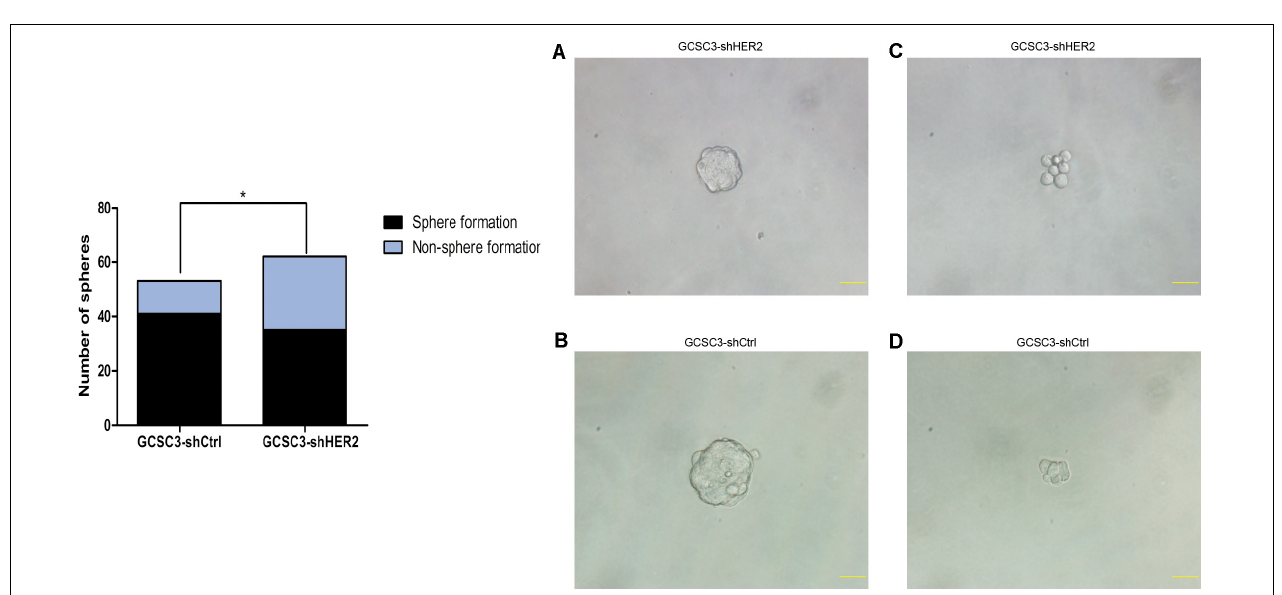
FIGURE 1 | Construction of stable transformants. (A) Transfection efficiency detected by Western blot; GCSC3 had the highest efficiency of HER2 knockdown. (B) Transfection efficiency of GCSC3 detected by RT-qPCR ( p < 0.01), ** p < 0.01. (C) GCSC3-shCtrl and GCSC3-shHER2 under a fluorescent microscope; representative pictures were taken at × 100 magnification, and scale bars represent 200 µ m.